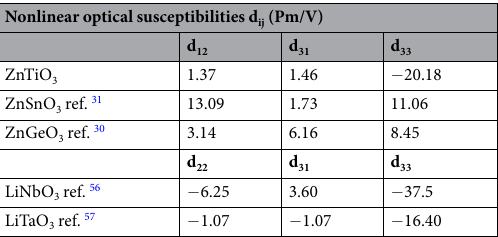
Nonlinear optical susceptibilities d ij (Pm/V)